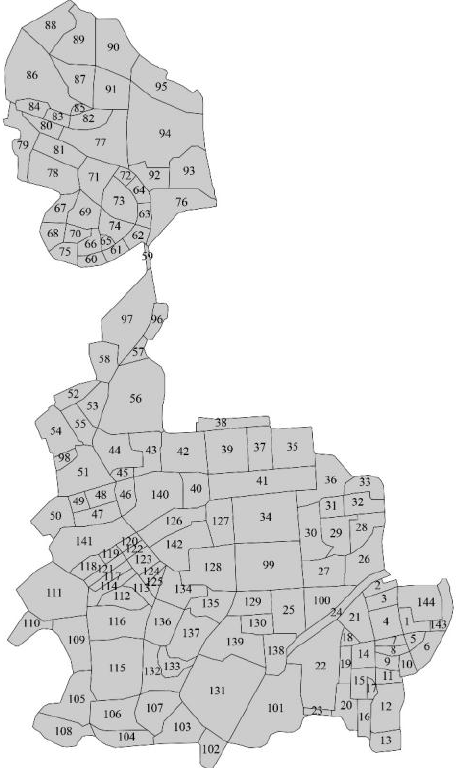
Figure 5. Numbered blocks.